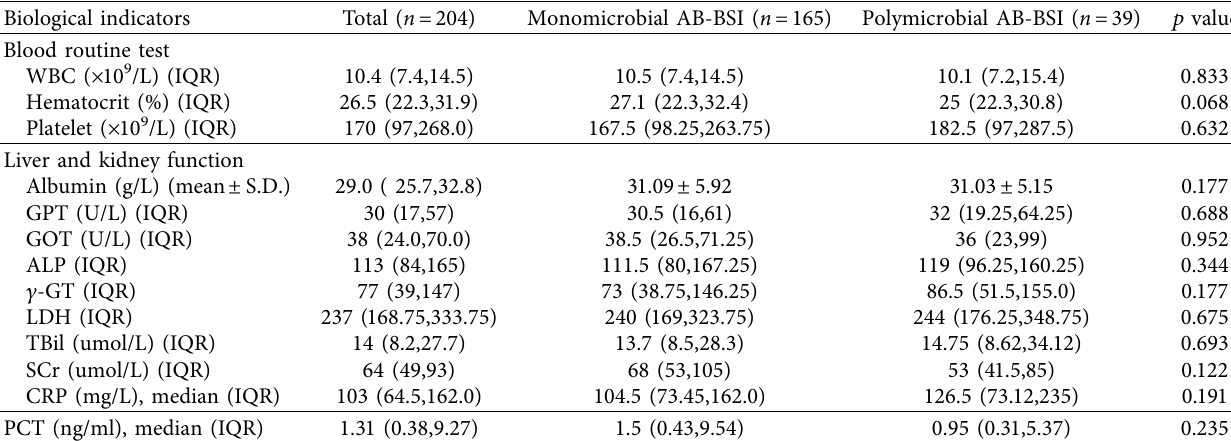
Table 2: Comparison of biological indicators between the groups of polymicrobial and monomicrobial AB-BSI.